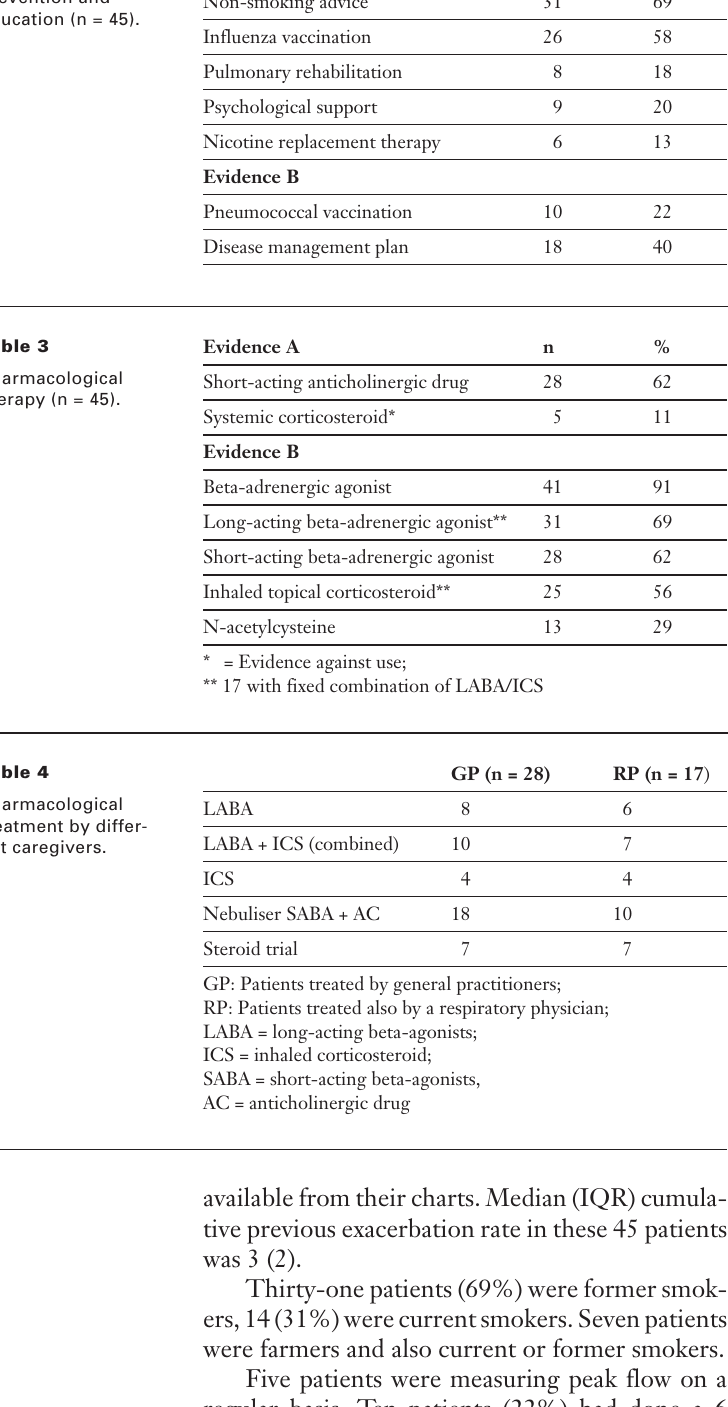
Prevention and education (n = 45).